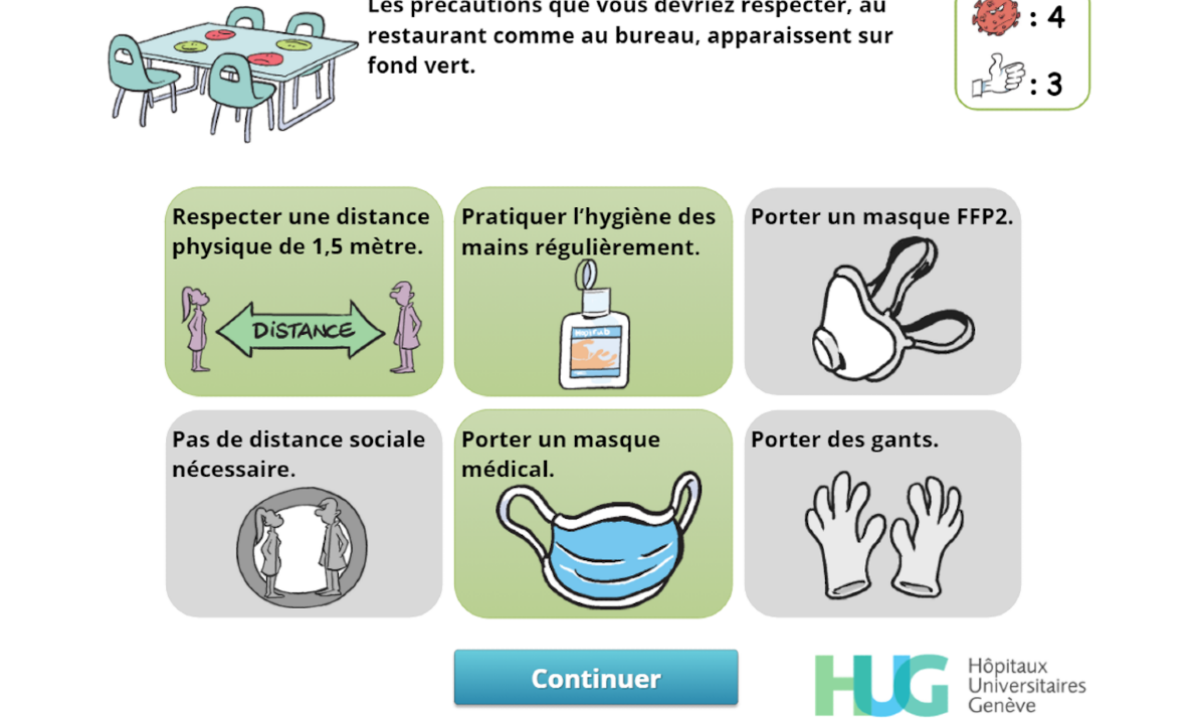
Each time the player performs a desirable action or selects the correct answer, a “thumbs up” is awarded. Conversely, the player gets a red virus for each incorrect answer or behavior. If the player accumulates a total of 5 viruses, a game-over screen